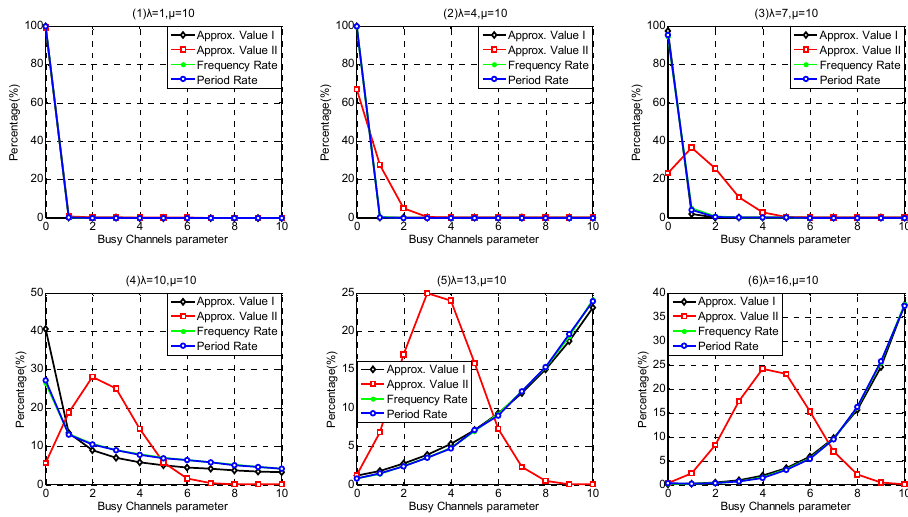
Figure 13. Busy-channel Parameter probability distribution under m -tolerated channel conflict model in Service-dependent coexisting WBANs.